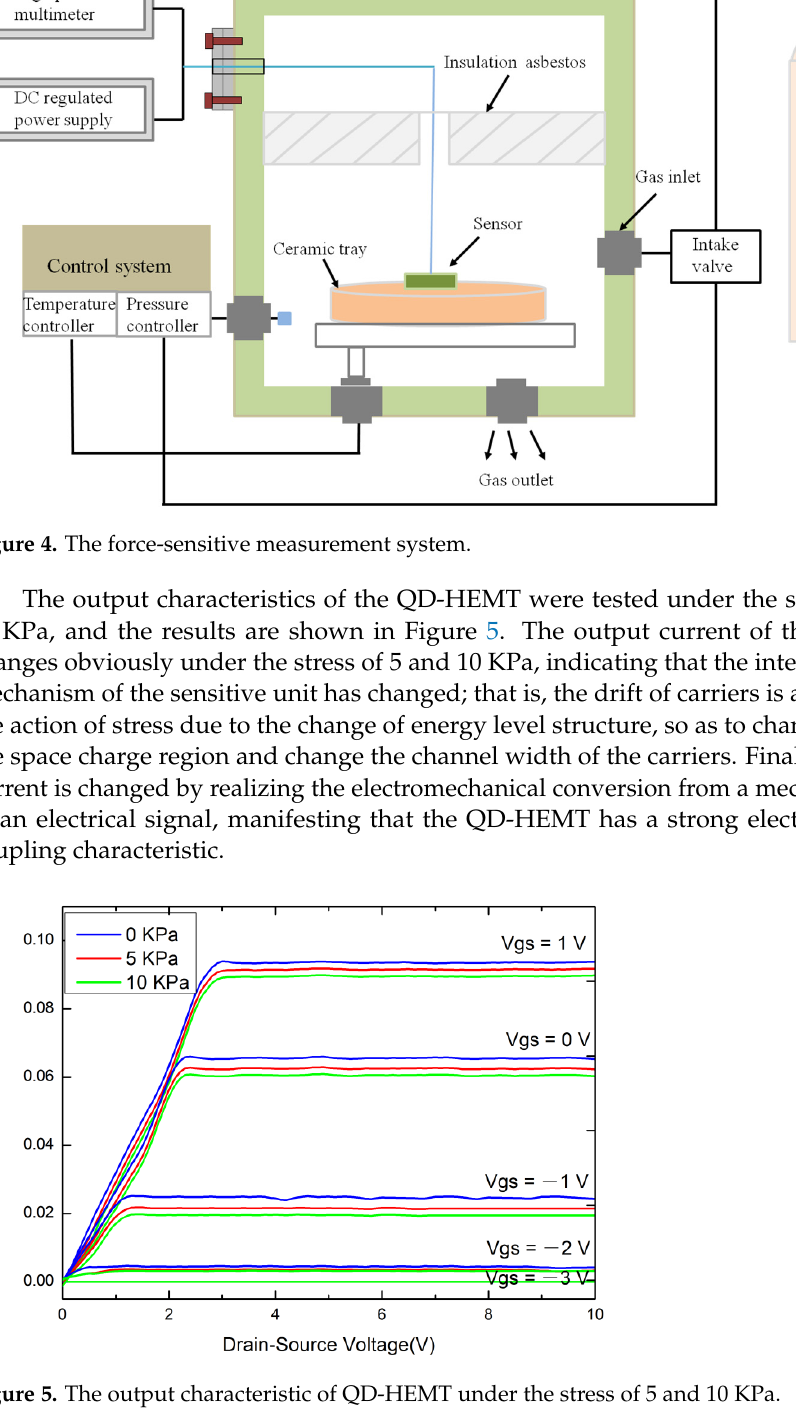
1 V. According to the test results, the sensitivity of the InAs QD-HEMT is 1.09 mV/KPa.